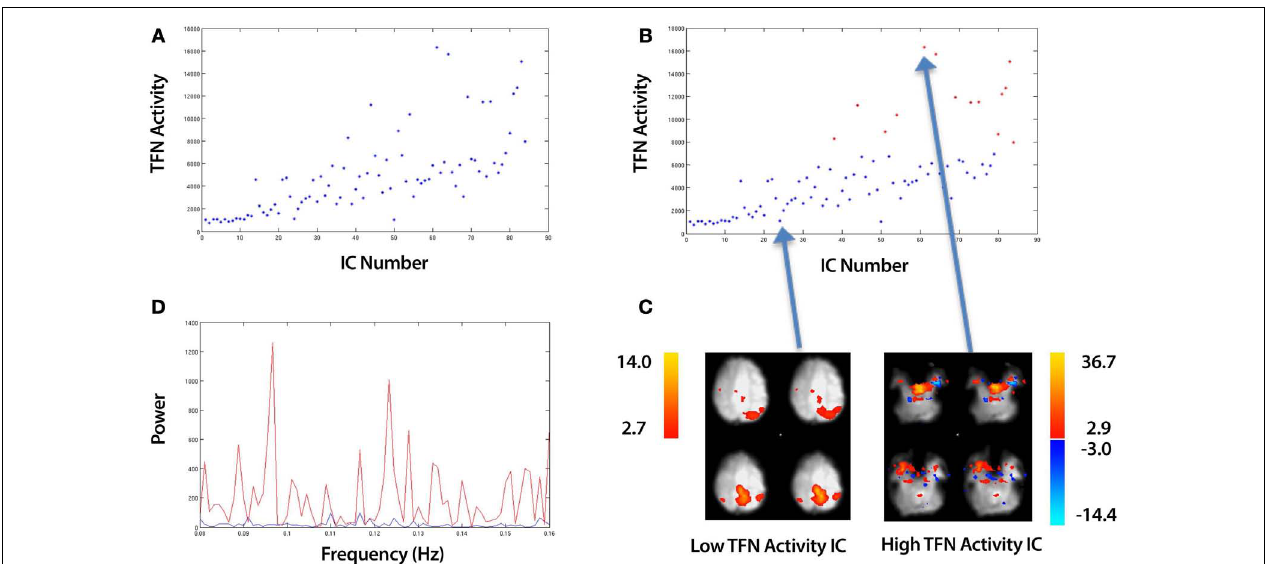
set of Low and HighTFN ICs. (C) A spatial map of the top and bottom points corresponding to the highest and lowestTFN activity ICs respectively. (D) The associated power spectra for these ICs with the blue and red curves representing the low and highTFN ICs respectively.This is a zoomed in view showing only frequencies beyond 0.08Hz which is the region of interest.